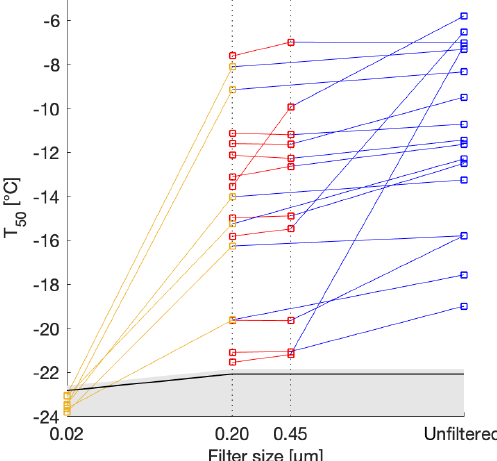
Figure 5. T 50 as a function of filter pore size for selected samples. The T 50 values of the background molecular biology reagent wa- ter are shown in black. The grey shaded area above the line repre- sents 1 standard deviation. The samples were filtered through 0.02, 0.20 and 0.45µm and the lines connect the different filtrates of the same sample. The T 10 version of this graph can be found in the Supplement for further comparison with Irish et al. (2017) and with Wilson et al. (2015).